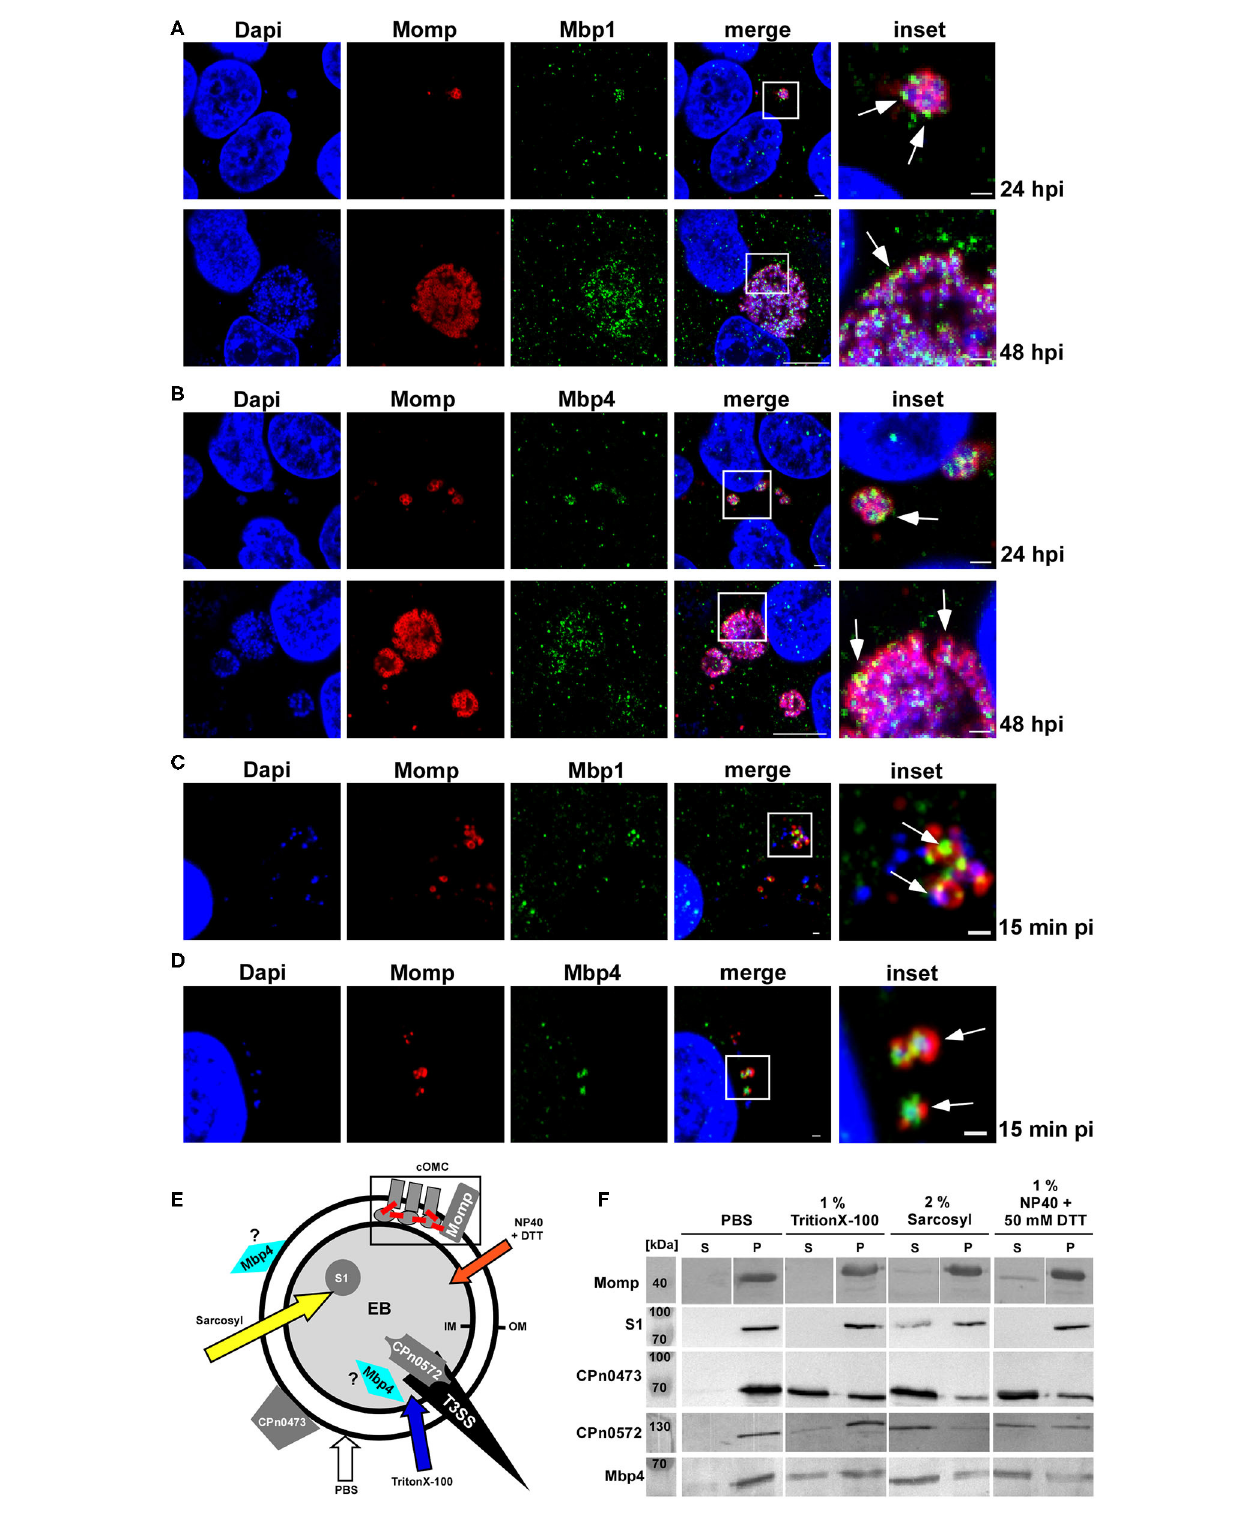
FIGURE 6 | Mbp11 and Mbp4 are expressed mid-/late in the infection cycle, colocalize with Momp and show a solubilization pattern similar to adhesins and type III secreted proteins. (A–D) Confocal images of mid-to-late Cpn inclusions (24 hpi; 48 hpi) of cells infected with an MOI = 1 (A,B) or of adhering Cpn EBs at 15min